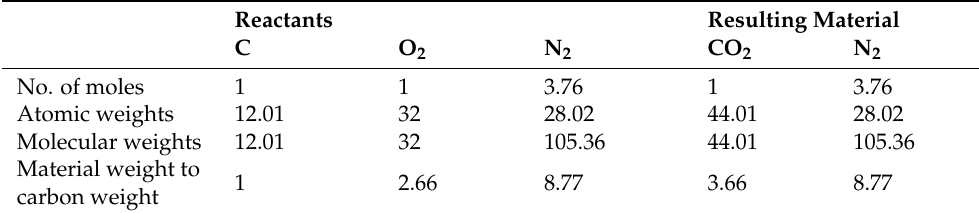
Figure 1. Methodology of emission specification for the proposed waste incineration plant (LCV denotes the lower calorific value and λ , the excess air). Table 2. The chemical properties of interacting carbon with air in the